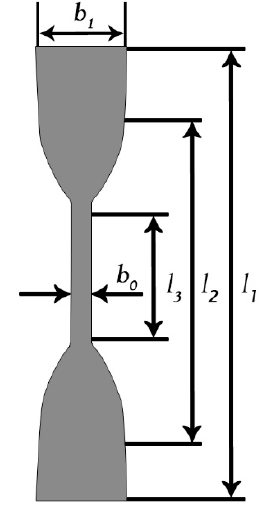
Table 1. Main magnetic properties of NdFeB magnetic bar.